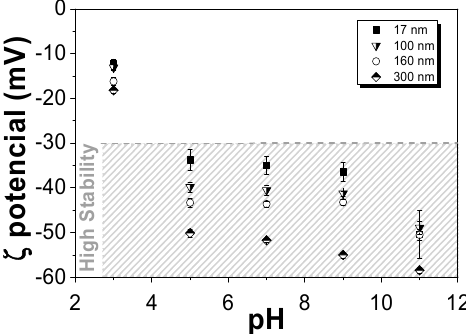
Figure 2. Zeta potential of the different SiNPs nanoparticles at different pH. The particles are considered more stable with a zeta potential above +30 mV or below − 30